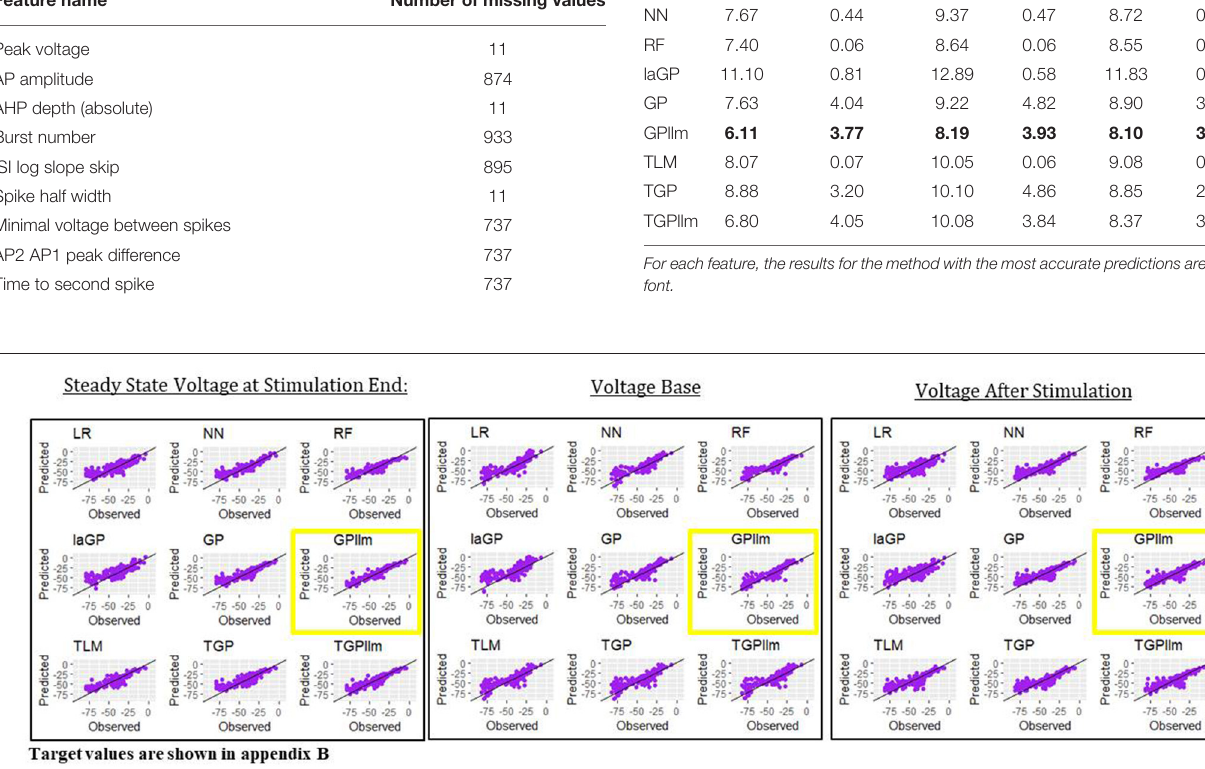
FIGURE 4 | Observed (i.e., simulated) vs. predicted (i.e., emulated) values for the three electrical features for each of the nine emulation methods considered here.